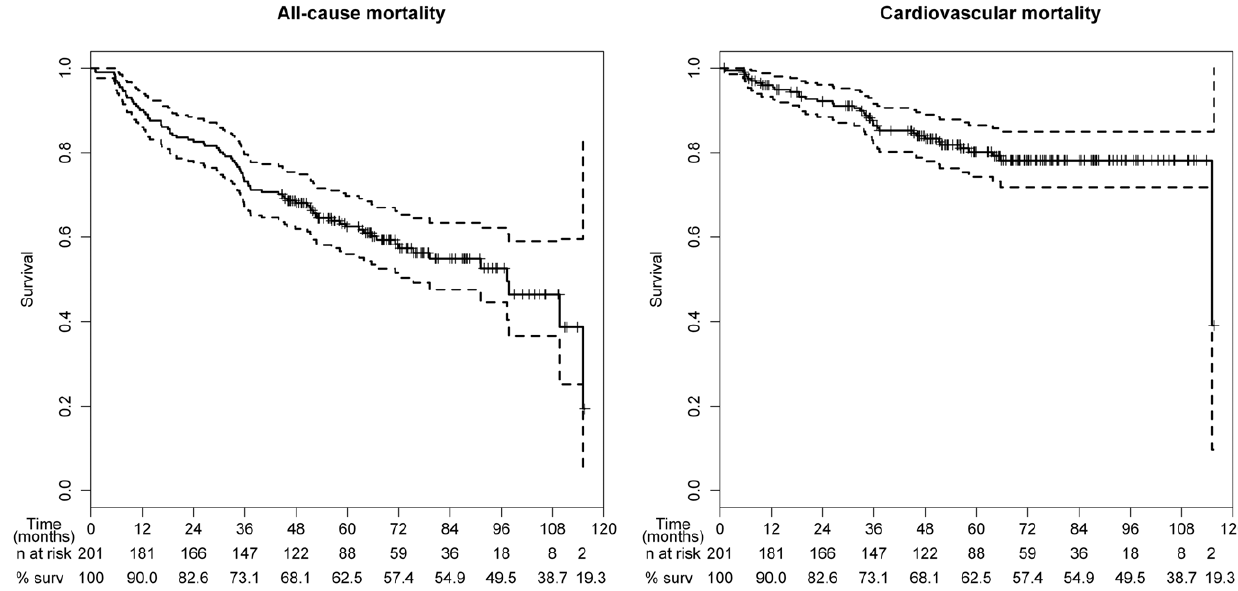
Figure 1. Kaplan-Meier survival curves with 95% confidence bands for all-cause and cardiovascular mortality. ‘‘% surv’’ stands for the percentage of survivors at each 12-month interval.